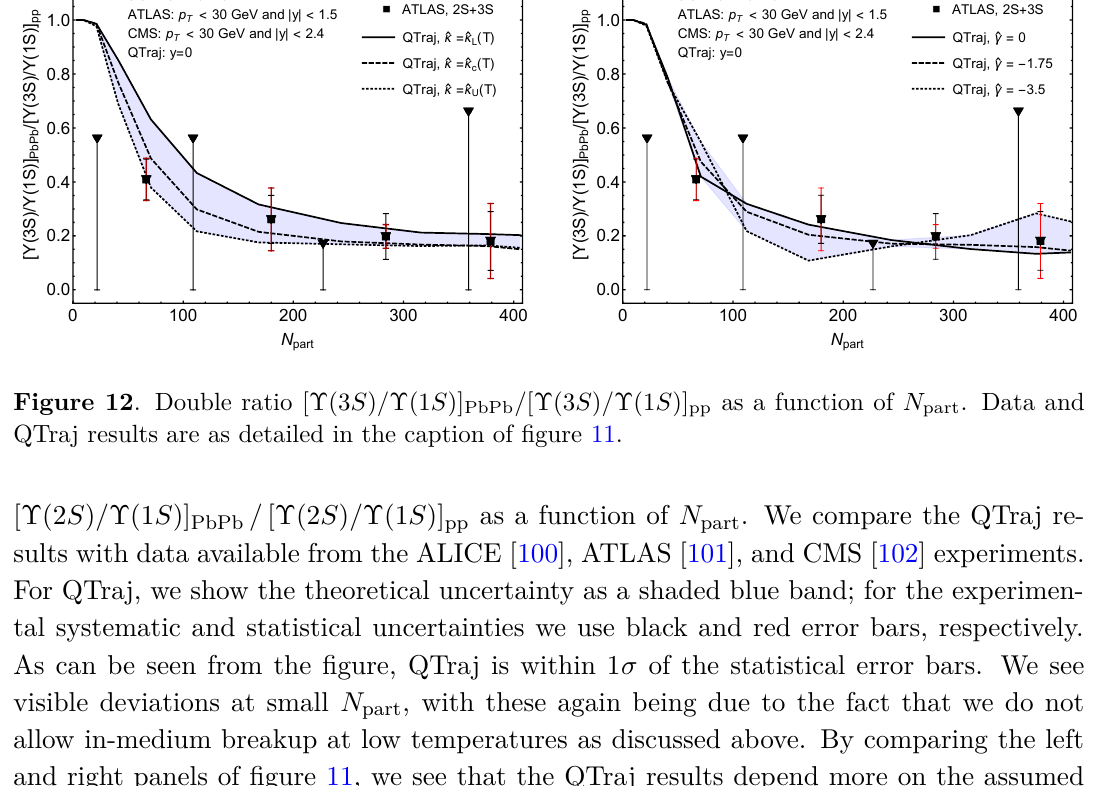
For QTraj, we show the theoretical uncertainty as a shaded blue band; for the experimen- tal systematic and statistical uncertainties we use black and red error bars,